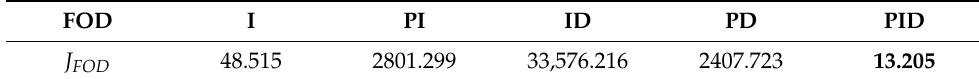
Figure 8. Comparison of the convergence performance for PSO, GOA, SSA, SHO, QSHO, and CSHO with QCSHO. Table 4. Comparison of controllers using QCSHO and ISWAE.